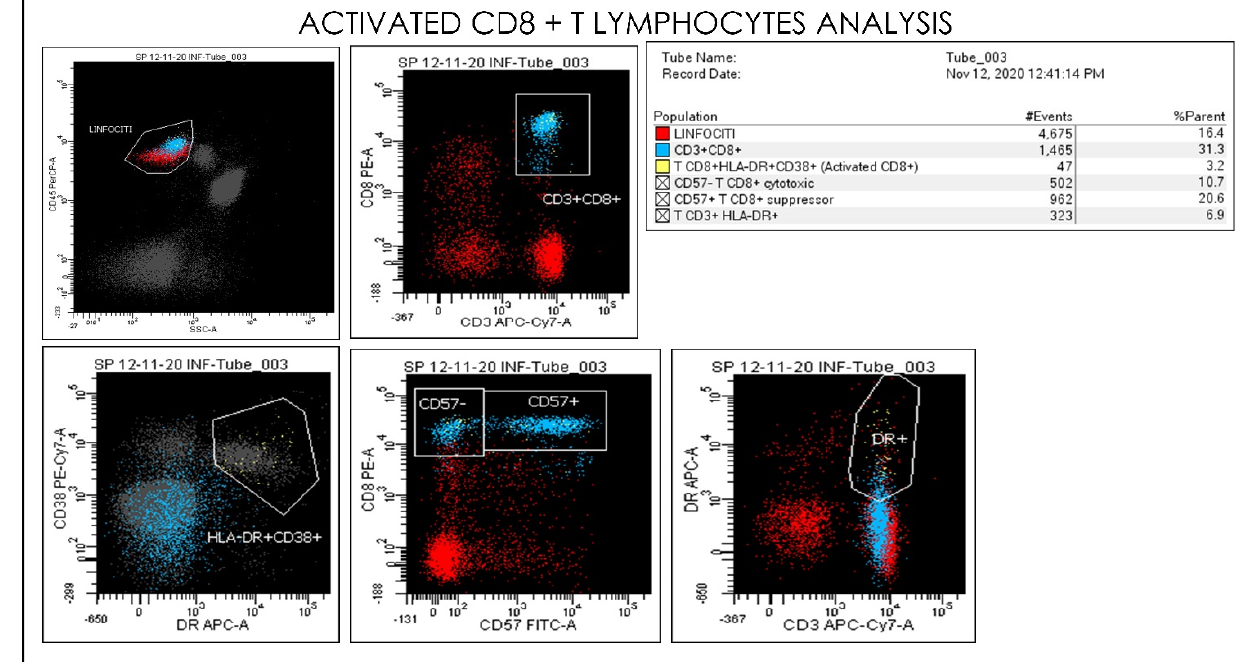
Percentages of positive cells were determined after gating on CD45 positive cells following the doublet exclusion.